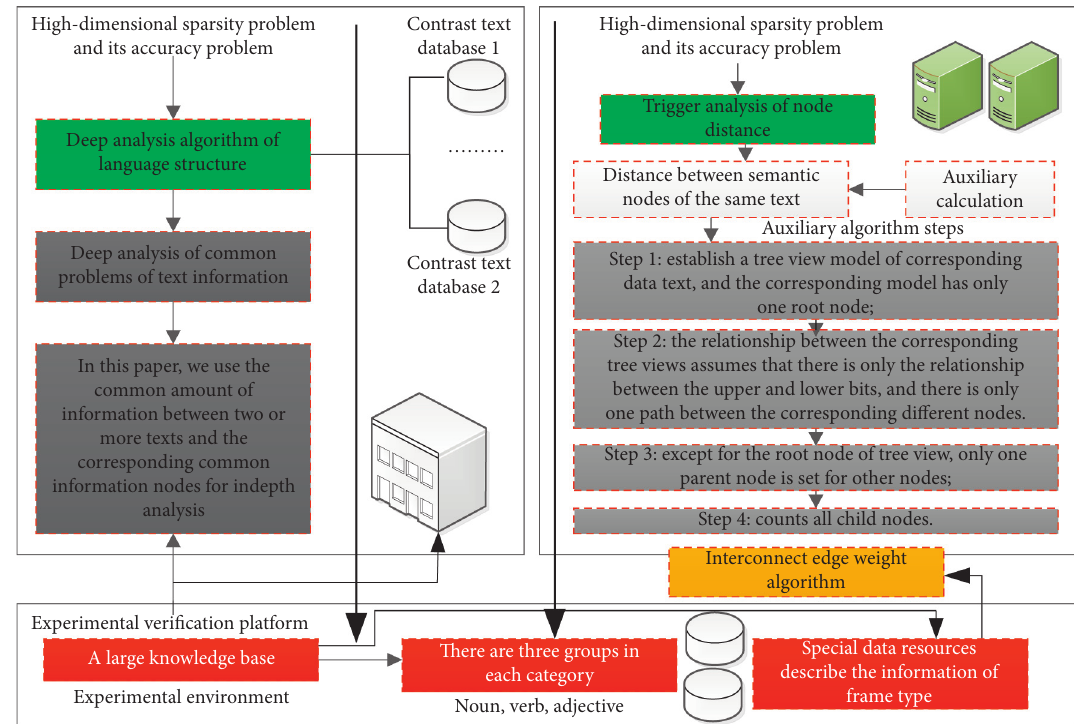
Figure 1: Schematic diagram of the improved semantic similarity algorithm based on linguistic concept